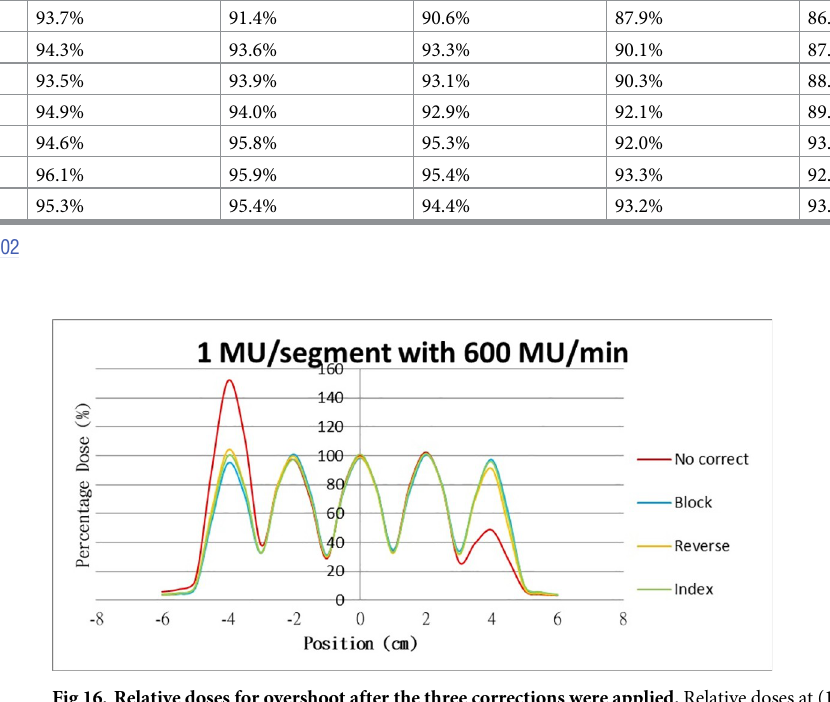
Fig 16. Relative doses for overshoot after the three corrections were applied. Relative doses at (16) 1 MU, 600 MU/ min; (17) 2 MU, 600 MU/min; and (18) 3 MU, 600